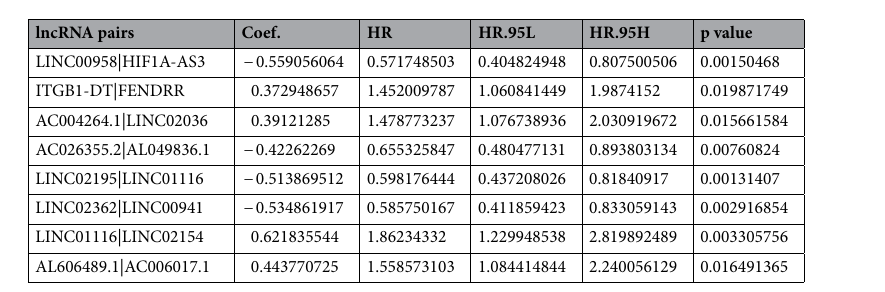
Table 2. Immune-related lncRNA pairs used for construction of prognostic model.